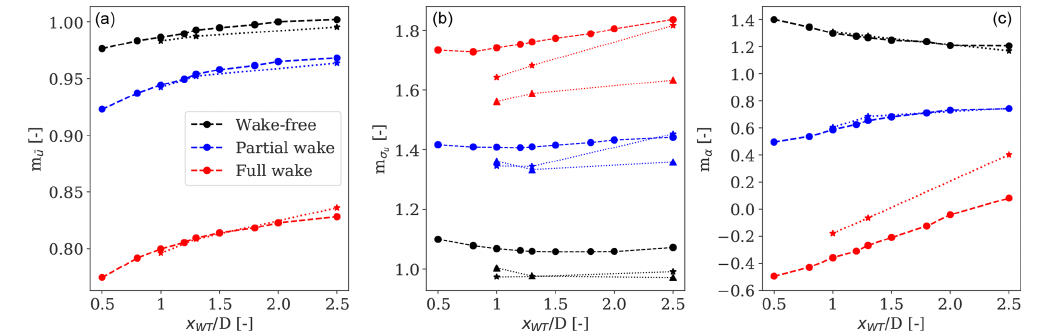
Figure 6. Comparison of the slope of a linear regression model between lidar-estimated and mast-measured inflow characteristics including mean wind speed (a) , the standard deviation of wind speed (b) , and shear (c) , when the turbine is operating in wake-free (black), partial-wake (blue), and full-wake (red) conditions and the met mast measures free-wind conditions. Results are shown as a function of lidar measuring distances in front of the rotor and normalized over rotor diameter. The results for the PL lidar are shown by the dashed line with circle markers, whereas those for the CW lidar are shown by the dotted line with star markers. The triangle markers show unfiltered turbulence obtained from the ensemble-average Doppler spectrum of the CW